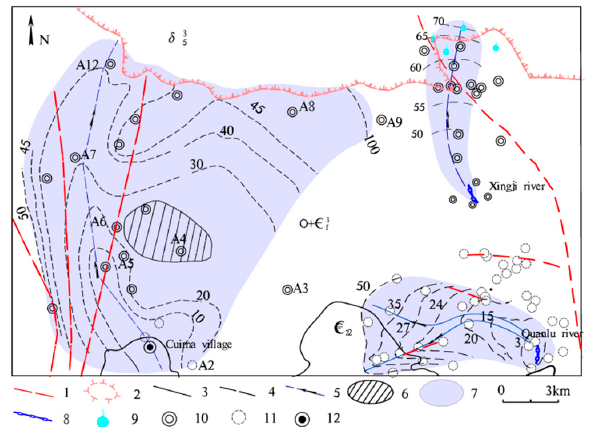
Figure 10. Schematic diagram of tracer test movement. 1: fault; 2: magmatic rock; 3: Cambrian Fengshan Formation bottom limit; 4: tracer diffusion concentration isochrons; 5: tracer transport direction; 6: tracer undetected area; 7: tracer detection range; 8: tracer drop river; 9: spring groups; 10: Cambrian Zhangxia aquifer monitoring point; 11: Ordovician aquifer monitoring point; 12: tracer drop point.